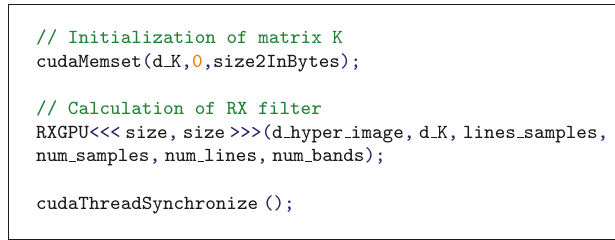
Figure 10: Portion of code which calls the CUDA kernel RXGPU designed to calculate the RX filter (in parallel) in the G-RX implementation.